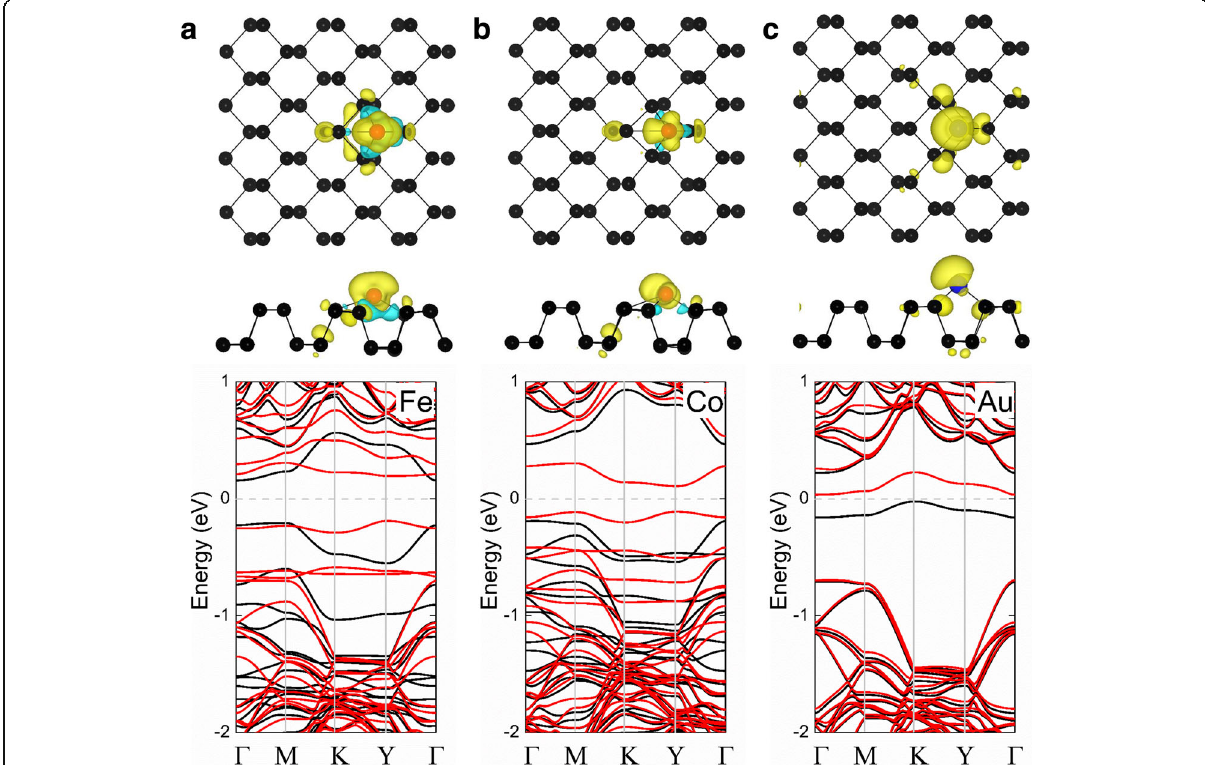
Fig. 2 Spin densities of the a Fe-phosphorene, b Co-phosphorene, and c Au-phosphorene systems are shown in the top row; the corresponding band structure of each system is shown at the bottom row. The black and red spheres represent P and TM atoms, respectively. In the top row, a plot of the spin-polarized charge density with a charge density iso-surface value of 0.002 e/Å 3 is superimposed on the top and side views of the crystal structure of pristine phosphorene for each of the TM-phosphorene systems; the yellow and cyan regions correspond to the up and down spins, respectively. In the plot of band structures (bottom row), the black and the red lines denote spin-up and spin-down channels, respectively; the Fermi level is set to zero, and it is indicated by the gray dashed